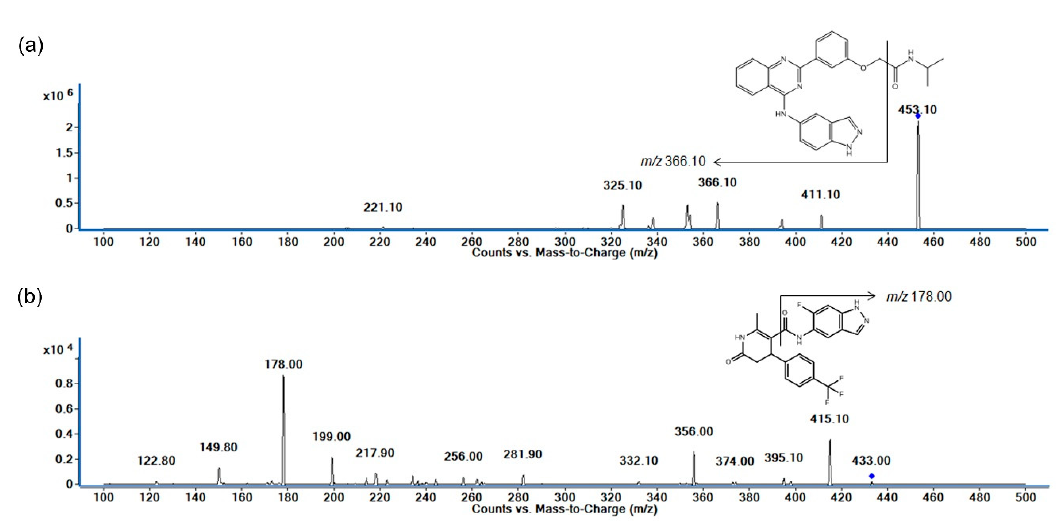
Figure 1. Representative product ion spectra of ( a ) KD025 and ( b ) GSK429286A (internal standard: IS) in positive ionization mode.